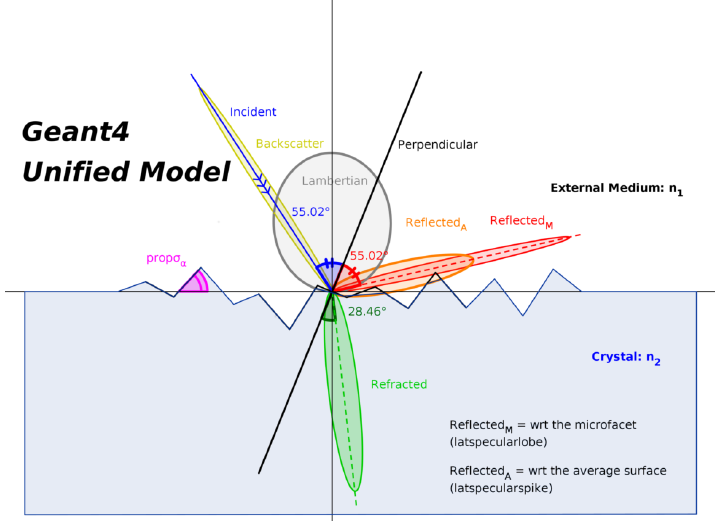
Figure 9. Representation of the UNIFIED model of Geant4, developed to describe optical interfaces between dielectric media with different refractive indices. One parameter that plays a central role is σ α (pink angle). Every time an optical photon impinges on this surface, a random angle is picked from a Gaussian distribution: the sigma of this Gaussian is the σ α . The surface, only for this specific photon, is no longer flat, but tilted by this angle (micro-facet). The higher the σ α , the higher the probability to have a big fluctuation of this modeled “roughness”. The photon can be then reflected or refracted with respect to the new micro-facet (Geant4 parameter latspecularlobe, red lobe in the picture). Several other lobes are available in the UNIFIED model: Geant4 parameter latspecularspike, orange lobe, which describes the probability of reflection with respect to the original flat surface; Lambertian, grey lobe, which holds the probability of Lambertian diffusion; backscatter, light green lobe, is used to set the backscatter